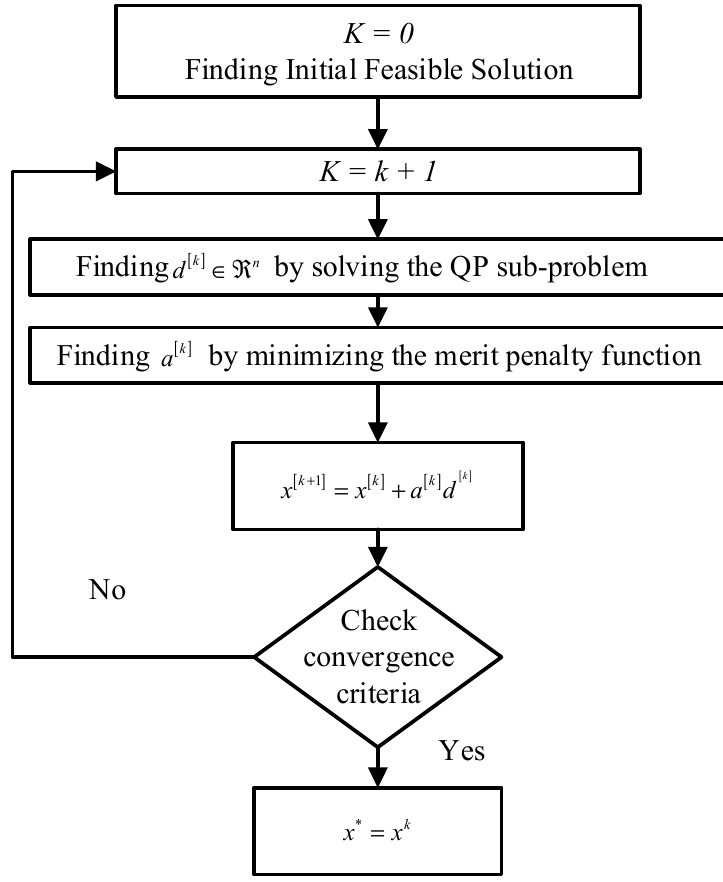
Figure 1. Flowchart of recursive quadratic programming.